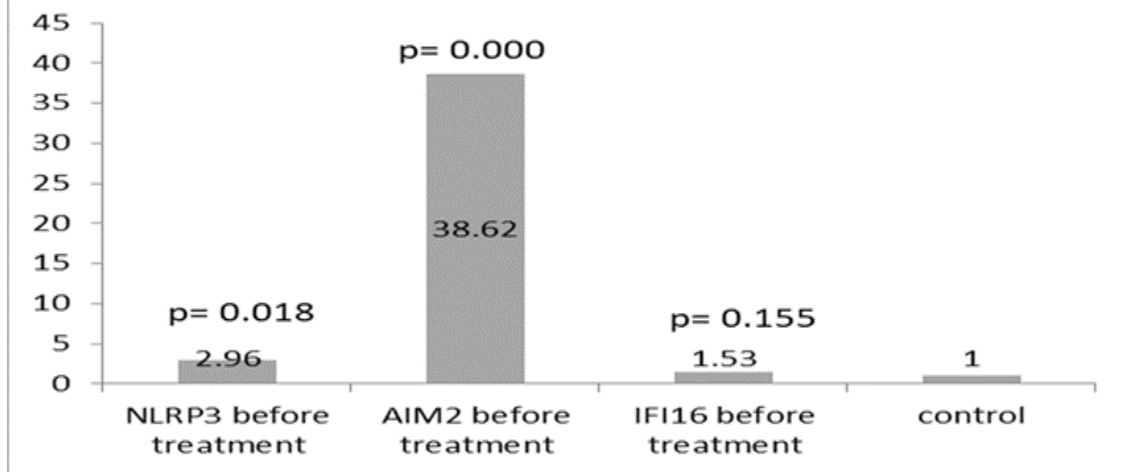
Figure 1. Showing the effect of HCV infection on the expression of genes of NLRP3, AIM2, and IFI16 inflammasomes in chronic HCV patient compared with healthy controls. Data expressed as median.